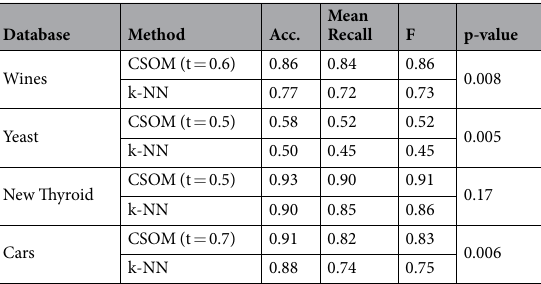
Table 3. Results obtained using k-NN and CSOM applying 10-fold cross-validation. The effect of the threshold values (t) were studied individually for each data set (see supporting information, Fig.